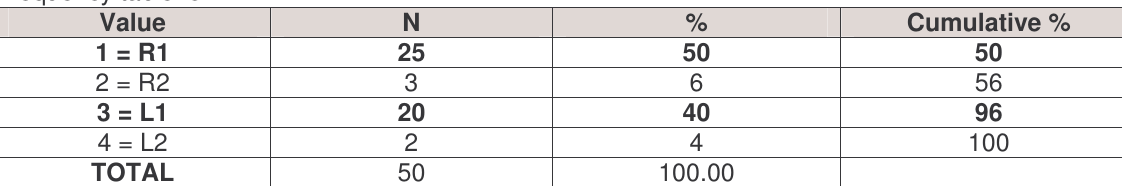
Table 4: NBI primary brain quadrant Frequency table for BRAINPREF